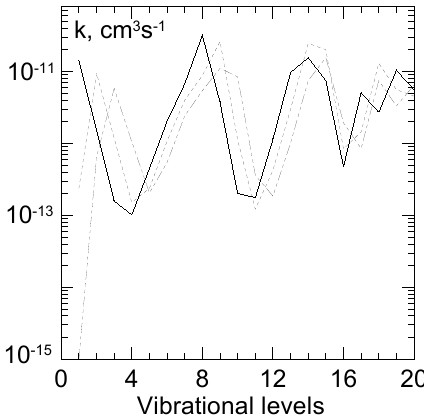
Fig. 13. The calculated total quenching rate coefficients of O 2 ( b 1 6 + g , v )+O 2 (X 3 6 − g , v =0, 1, 2) at a temperature of 300K Figure 13. The calculated total quenching rate coefficients of O 2 (b 1 Σ g+ ,v) + O 2 (X 3 Σ g– ,v=0,1,2) at (solid, dotted and dotted-dashed lines, temperature of 300 K (solid, dotted and dotted-dashed lines, respectively)